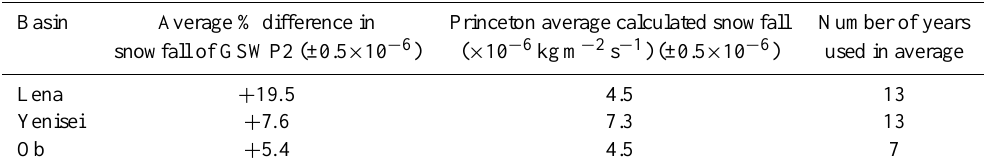
Table 1. Comparison of GSWP2 driving snowfall data to calculated snowfall data derived from Princeton precipitation data. The comparison is only made between 1 st December and 31 st March since outside of this period there is much rainfall. Therefore, the averages are not representative of the whole year since seasonality of snowfall varies between